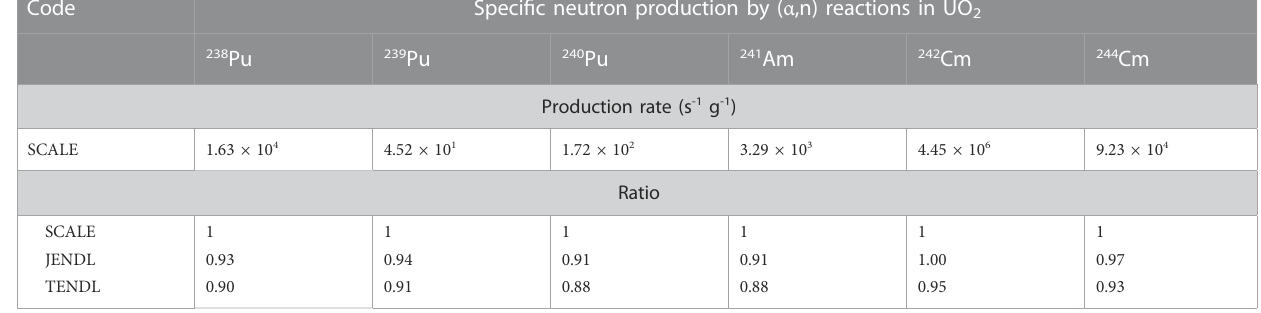
TABLE3Speci fi cneutronproductionby( α ,n)reactionsinUO 2 ,i.e.,neutronemissionratepermassofnuclide.Thespeci fi cneutronemissionratesadoptedinSCALE are compared with those derived from a combination of stopping powers in ASTAR (NIST, 2023) and ( α ,n) cross sections in TENDL-2021 (OECD NEA, 2023) and JENDL-AN/2005 (Murata et al., 2006). The latter are given relative to those adopted in SCALE. Code